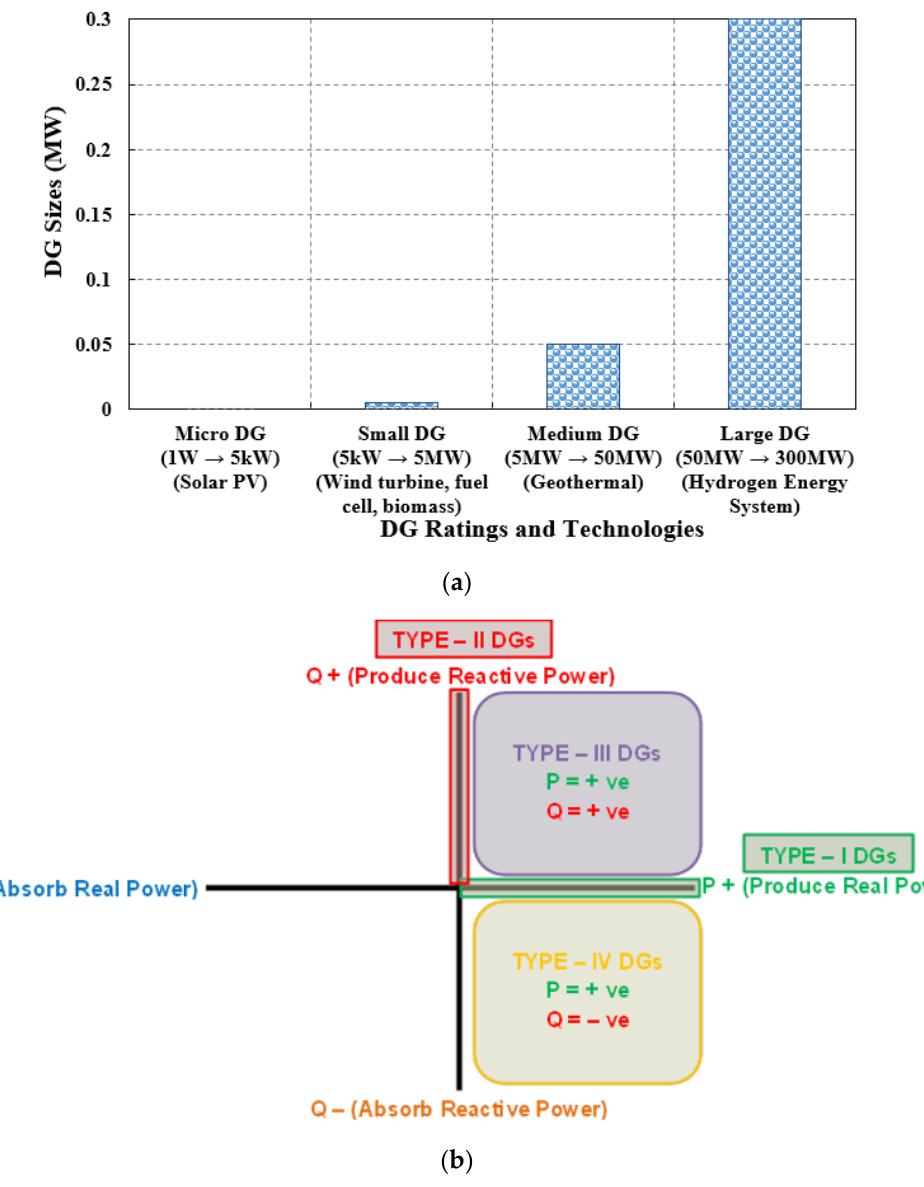
Figure 1. ( a ) DG power rating levels, technologies ( b ) DG types